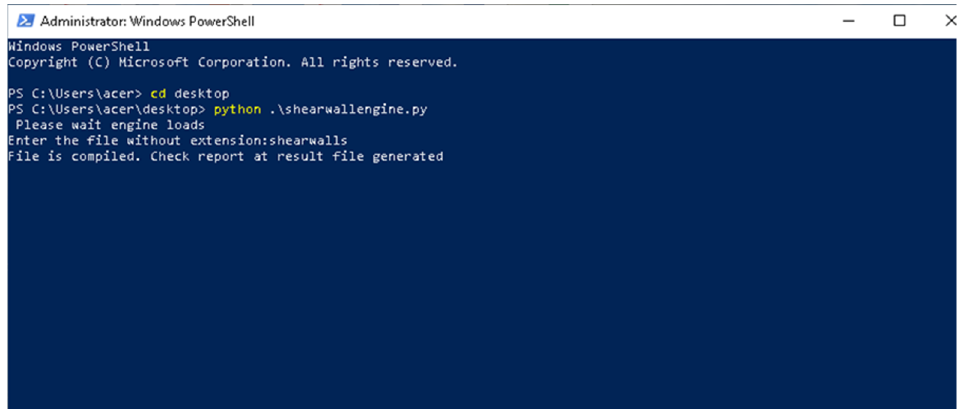
Figure 14. File compiled in the command window.